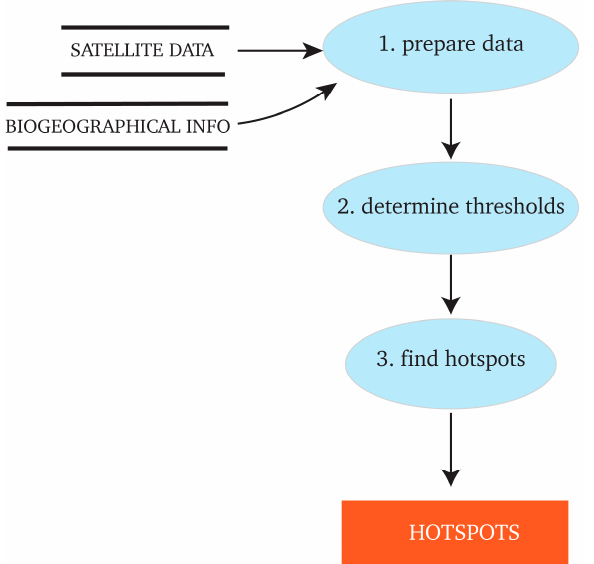
Figure 1. Overview of the workflow for the implementation of the modified BRIGHT algorithm.